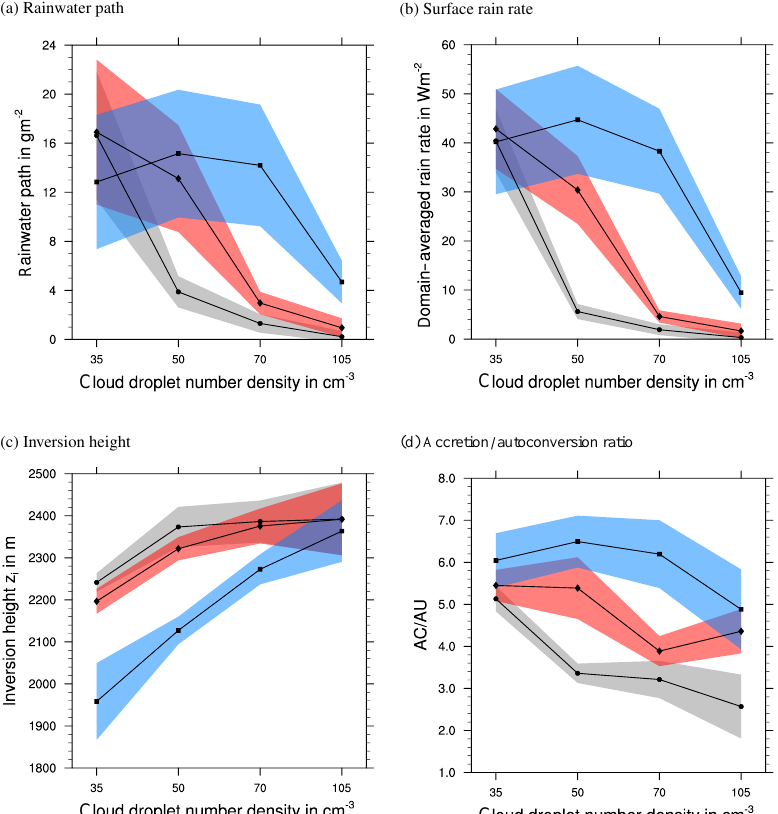
Figure 6. Sensitivity of LES results to variations in the cloud droplet number density. Shown are the rainwater path, surface rain rate, inversion height, and accretion/autoconversion ratio for the three different collection kernels of the control simulations using the purely gravitational kernel (bullets, grey shading), the Ayala–Wang kernel (squares, blue shading), and the Onishi kernel (diamonds, red shading). The shaded area indicates the standard error at a 95% confidence